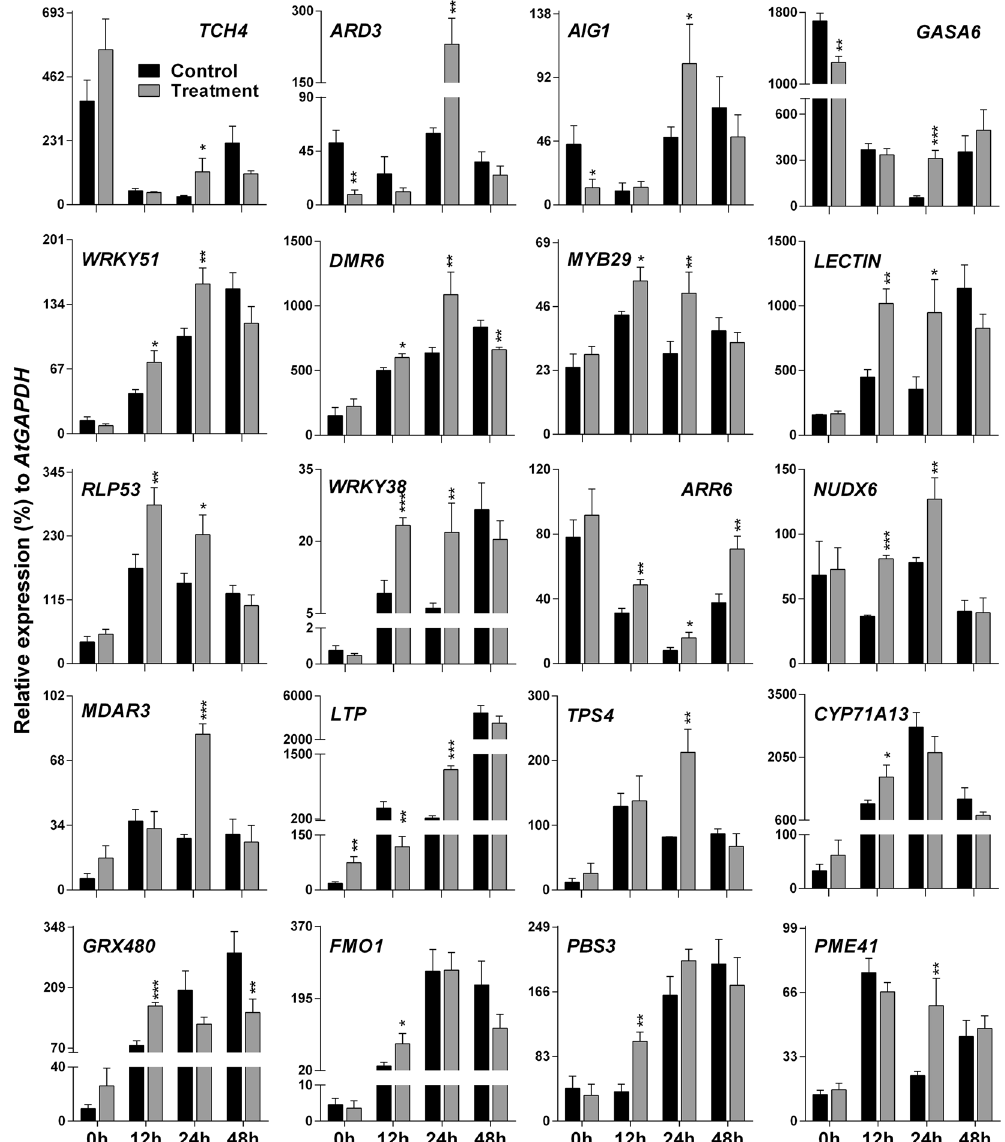
Figure 4. Validation of microarray data using qRT-PCR. Microarray results of twenty representative genes are confirmed by qRT-PCR. Expression of each gene in the A . thaliana exposed to a 1000 Hz sound vibration (gray) was compared with that of control plants (black). AtGAPDH was used for normalization. Bars represent mean and standard error of three biological replications. The time (0, 12, 24 and 48 h) indicates h post inoculation (hpi). Details of genes and their fold changes in microarray experiment are available in Table 1. P- value ranges are marked by asterisks: *** P < 0.01, ** 0.01 < P < 0.05, * P <